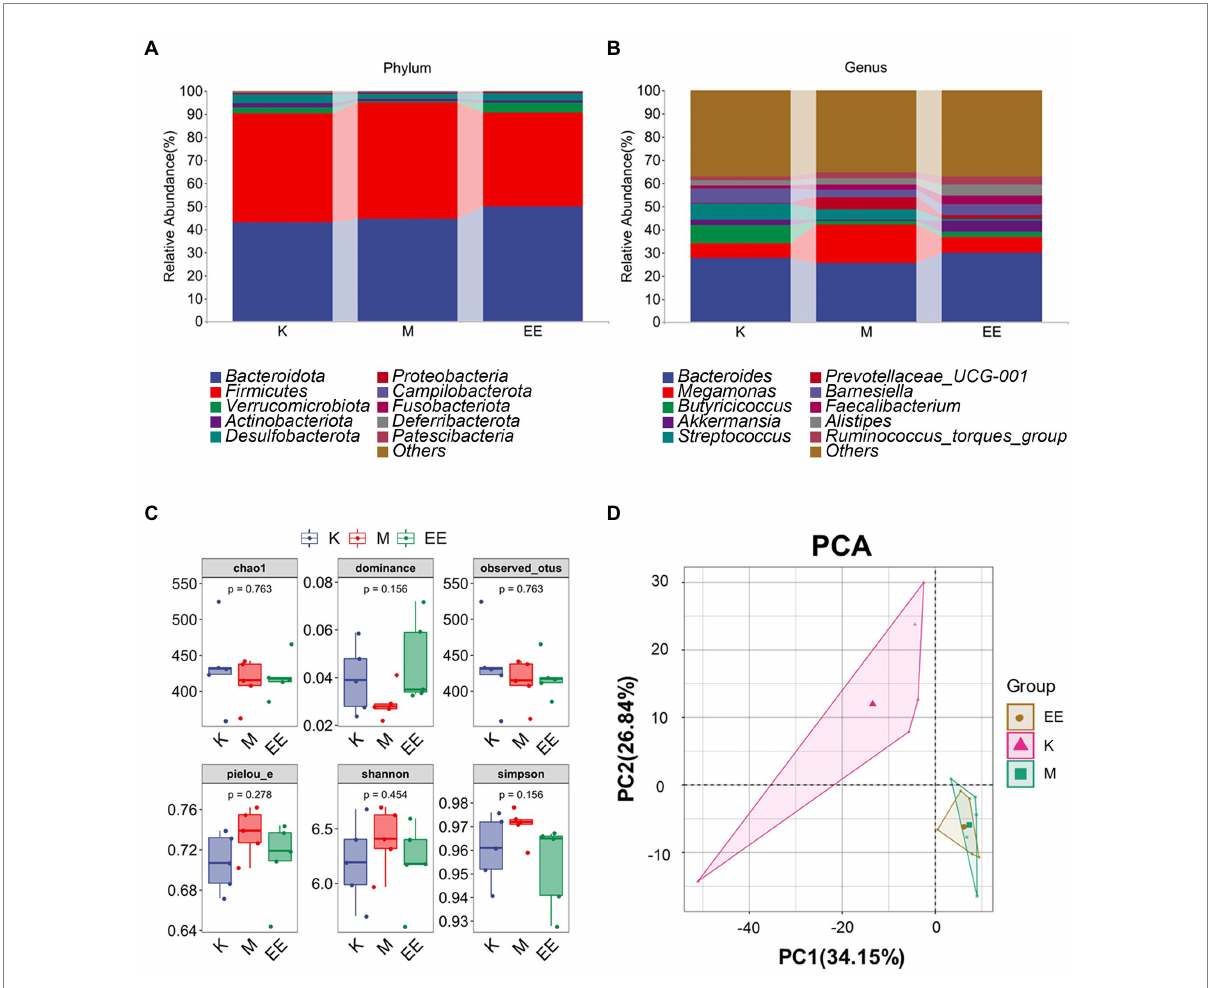
FIGURE 3 Regulation of gut flora abundance in immunosuppressed ducks by Echinacea purpurea. (A) Cumulative histogram of the top 10 species in relative abundance at the phylum taxonomic level; (B) Cumulative histogram of the top 10 species in relative abundance at the genus taxonomic level; (C) Box plot of the alpha diversity index; (D) PCA analysis of beta diversity. ( N =